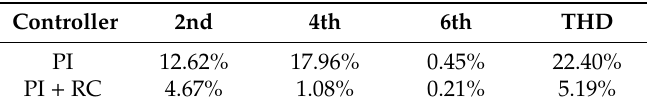
Table 3. Harmonic analysis result of the torque in the experimental